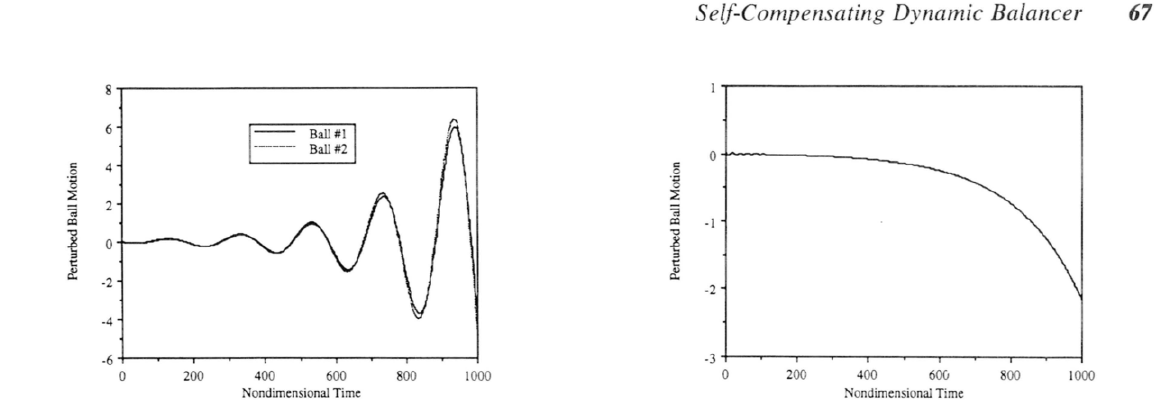
FIGURE 13 Perturbed ball motion versus nondi mensional time (w = 1.0). Initial conditions: i o(O) = .90(0) = 0.01 , i o(O) = Yo(O) = 0, cf>s) = 3.13, cf>s2 = 3.15, cf»(0) = cf>2(0) = 0.01 , ~)(O) = ~2(0) = 0, tn = 0.005, R = 0.001 , and {3 ' = .01.